Question: Summarize what this figure shows in one sentence.
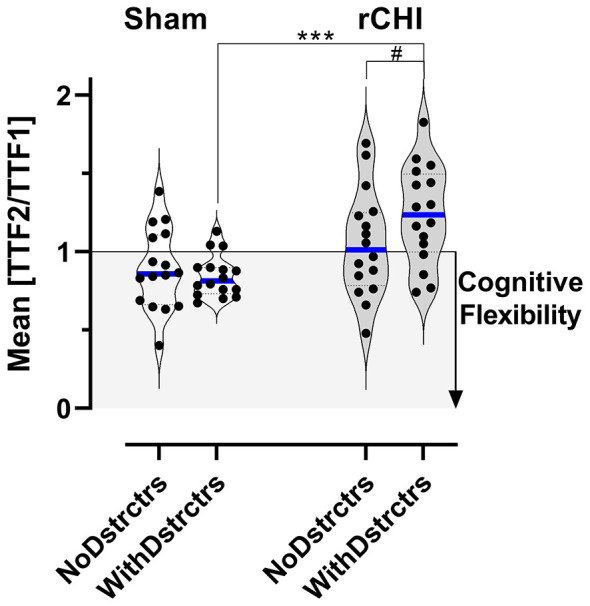
Answer: All mice demonstrated normal cognitive flexibility in a standard 40-hole Barnes Maze delayed-match-to-place task but deficits in cognitive flexibility are induced in rCHI mice but not sham mice when sensory distractors are present during testing. No sex differences were found so male and female animals were combined in both groups. Both sham and rCHI mice have time-to-find (TTF) ratios from paired escape hole locations that demonstrate normal cognitive flexibility on average ( p = 0.1415). A significant increase in the TTF ratio indicating poor cognitive flexibility (TTF2:TTF1 >1) was demonstrated in the rCHI mice only when auditory and tactile sensory distractors were present during the testing (*** p < 0.0001). The within group comparison of rCHI performance with and without distractors showed a trend towards significance ( # P = 0.055), while it was not different in the sham group with and without distractors. N = 16 per group; Individual animals are plotted for each group with Male (□), Female (°) indicated by symbol shape and color.